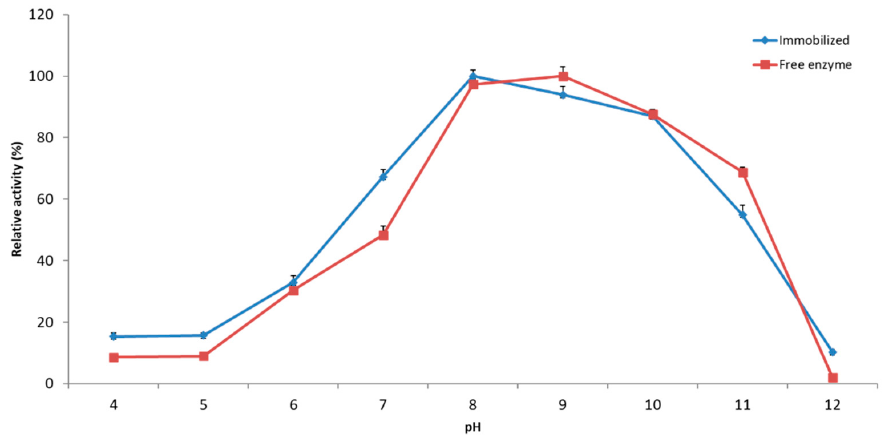
Figure 6. Effect of pH on activity of immobilized YT PTE. Red line: Immobilized YT PTE; Purple line: Free enzyme.